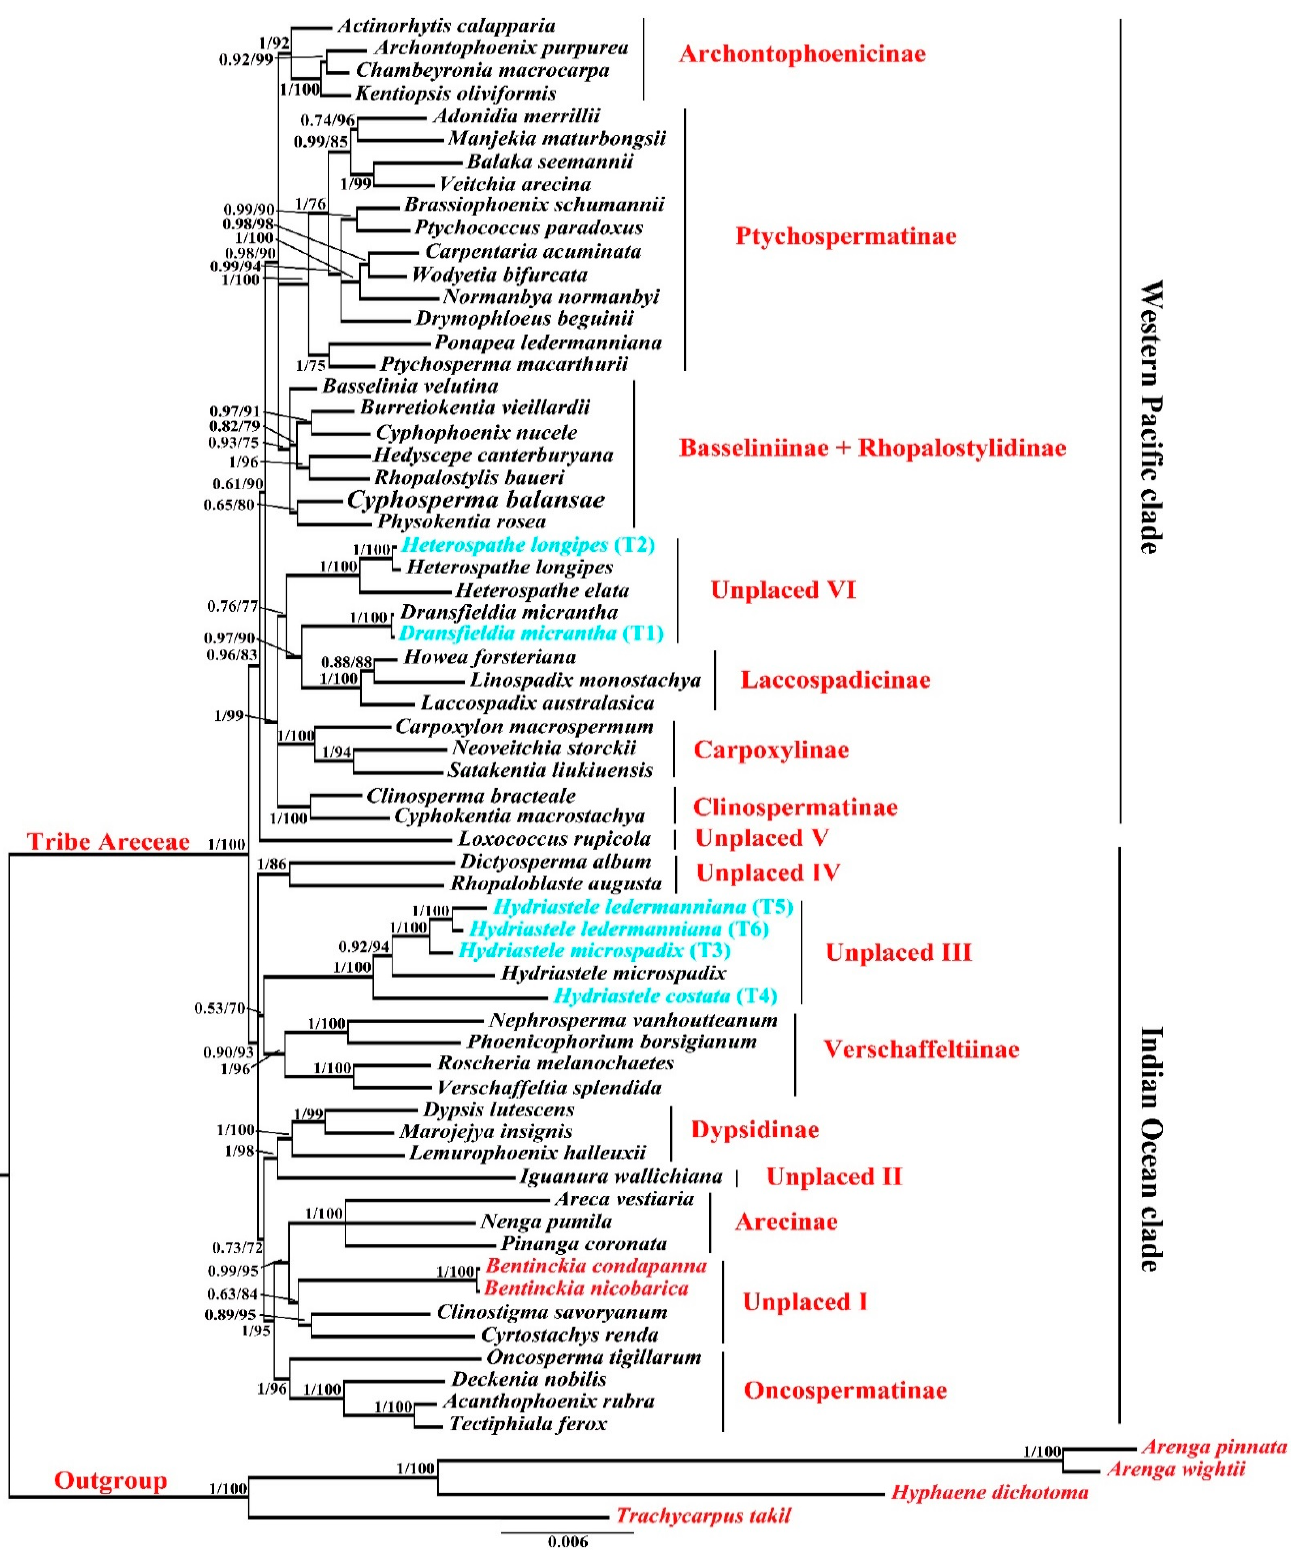
Figure 5. Bayesian phylogeny of the tribe Areceae based on a combined data matrix. BI posterior probability and MI bootstrap values (BI PP/ML BS) are given in front of respected branches. Red colour represents sampled species whereas blue colour represents revised names of species.